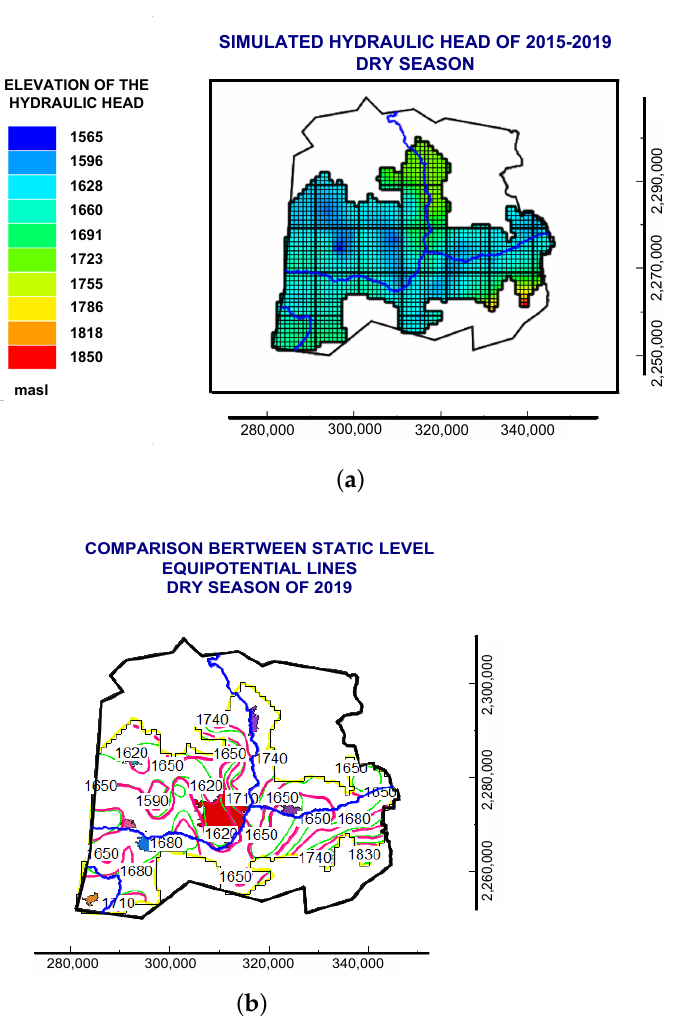
Figura 2.12: Comparaci´on entre l´ıneas equipotenciales de elevaci´on de nivel est´atico en Temporada de Secas, 2019. Figure 12. Dry season. ( a ) Values of hydraulic head in transitory state in the time interval 2015–2019. ( b ) Comparison between static level elevation equipotential lines calculated by the model (pink color) B Calibration in Transient State and those measured in the field (green color).